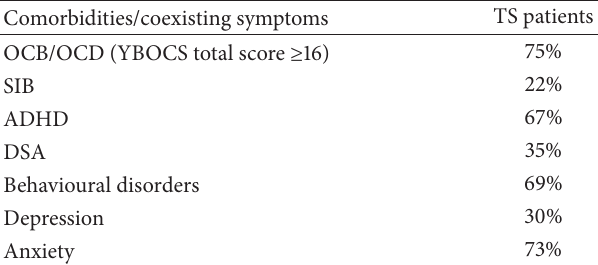
Table 2: Presence of comorbidity and associated symptoms in TS patients. Data are expressed in percentage (%). Comorbidities/coexisting symptoms TS